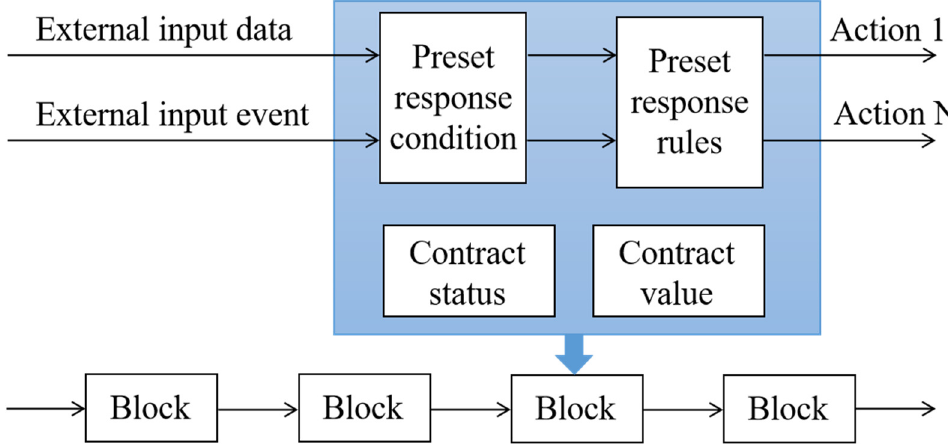
Figure 3. The operation mechanism model of a smart contract.